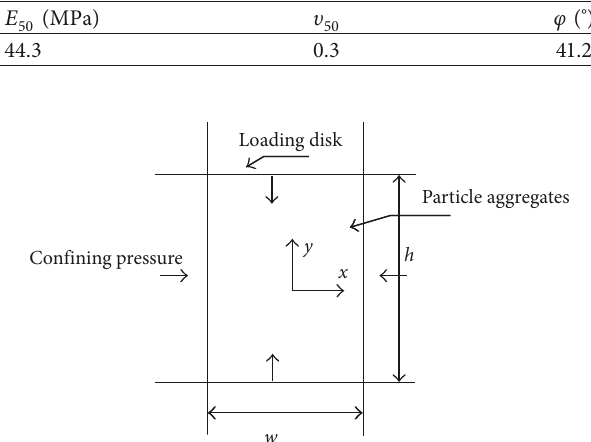
Table 1: Macroscopic parameters of Fujian sand in laboratory tests.